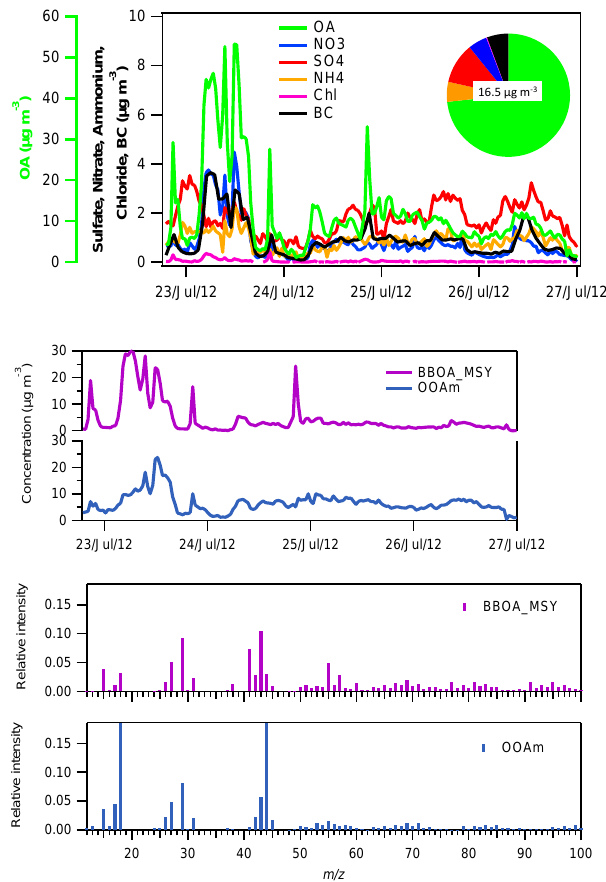
Figure 7. (a) Time series of ACSM components and BC concentra- tions and pie chart of the average chemical composition during the wildfire from 22 to 26 July 2012. (b) Time series of the contribu- tion of the BBOA_MSY and OOAm sources identified by PMF. (c) Source profile of the BBOA_MSY and OOAm